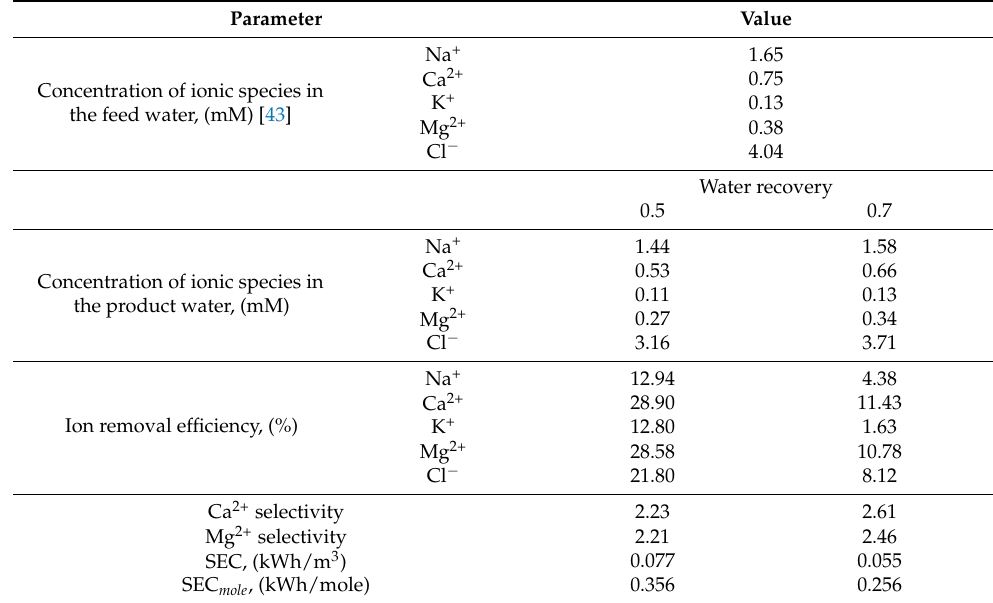
Table 4. Water softening performance and energy behaviors of quasi-steady state MCDI for slightly softening domestic tap